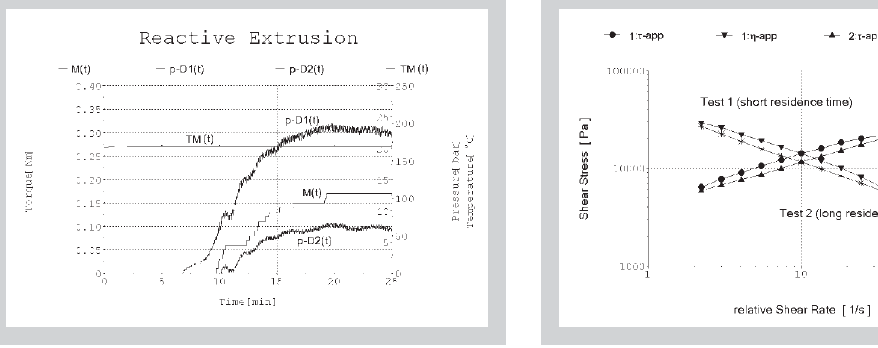
Figure 5 (left): Monitoring the reaction time online, polymerization of L-lactid to biodegradable polymers. Figure 6 (right): Influence of the residence time on the flow behavior of a PP